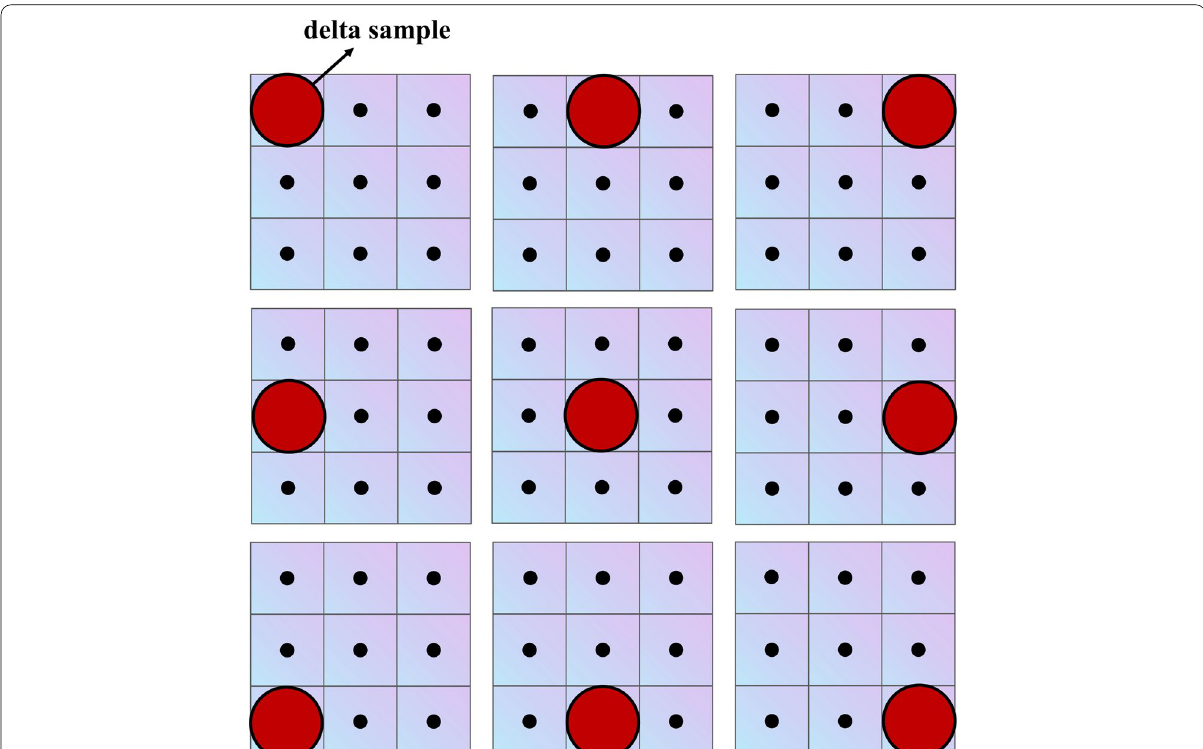
Fig. 3 Principle of measurement-based SM method of MPI using a delta sample (taking a grid of 3 × 3 as an example). A robot moves the delta sample to scan the location of each